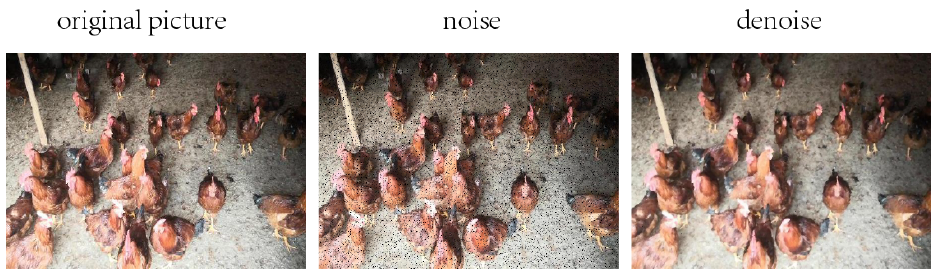
Figure 2. Adding salt and pepper noise and median filtering process.